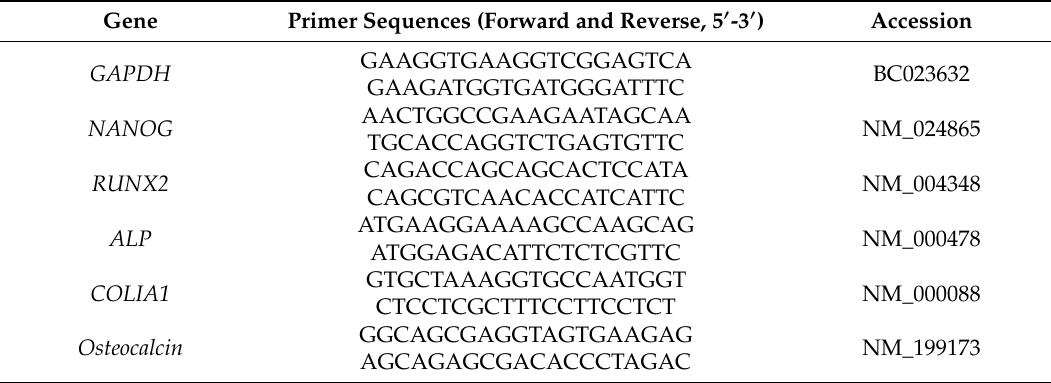
Table 2. Sequence information of primers used for quantitative real-time